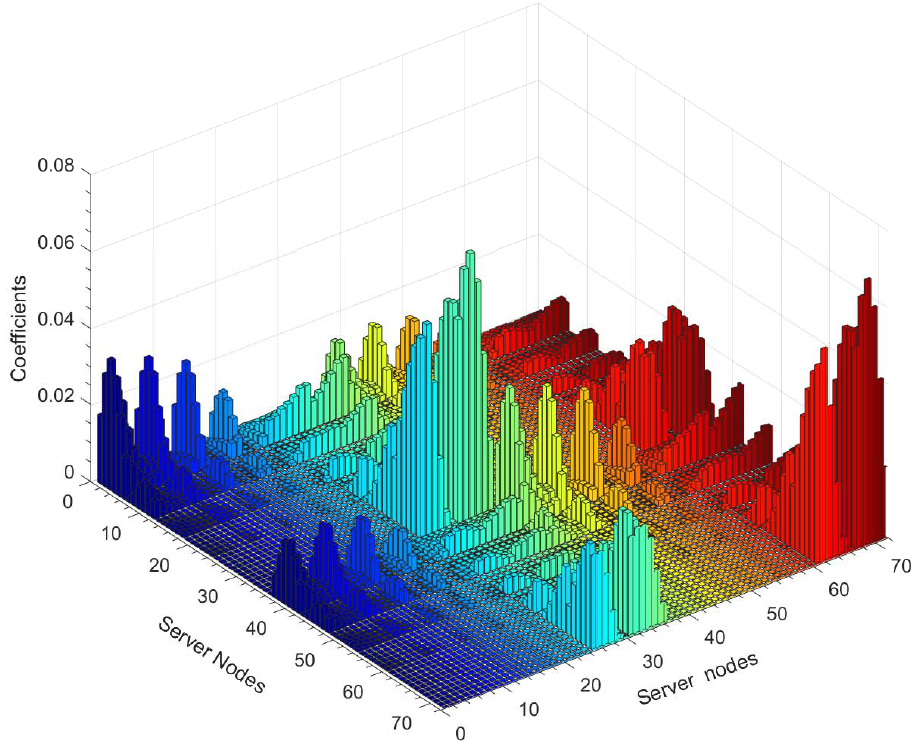
Figure 4. Cross-interference matrix A obtained by computational fluid dynamics (CFD)